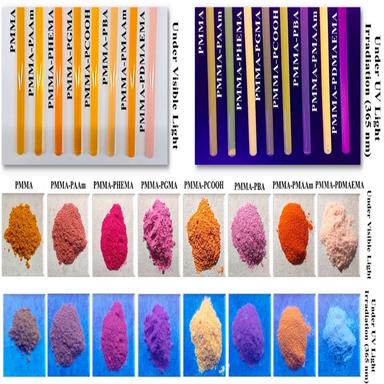
Solvatochromic properties of multi-color photoluminescent polymer nanoparticles in both of colloidal solution and solid state under visible-light and UV-light irradiations.